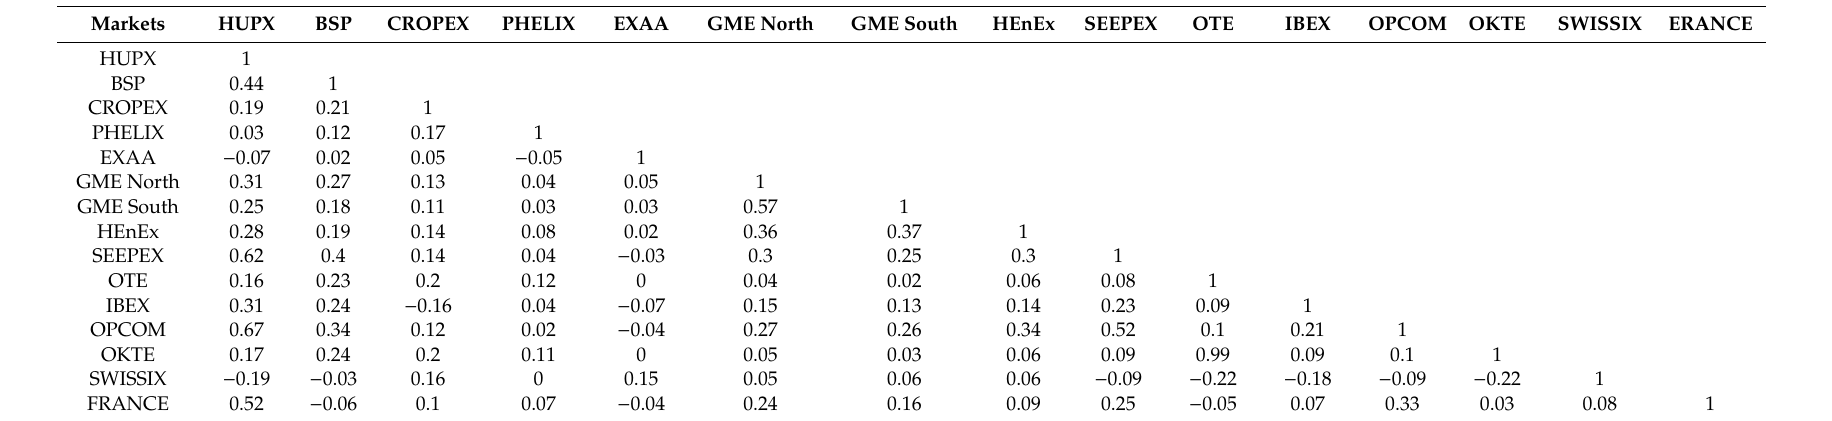
Table 5. Correlation matrix of DVDA between